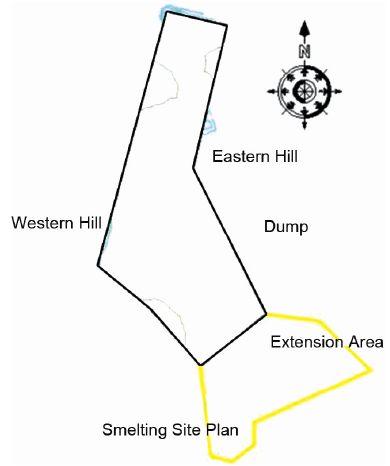
Fig 5. Site plan of Sungun Copper Complex (Karan Darya Co.